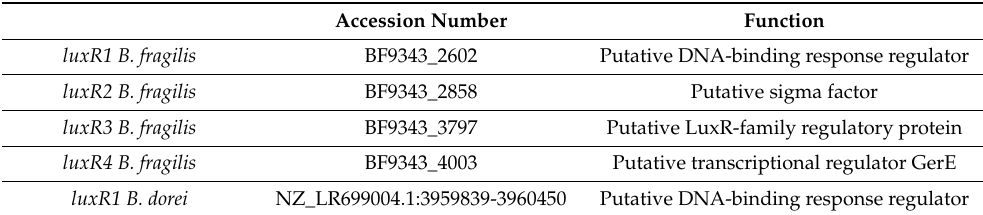
Table 2. Gene list from Bacteroides fragilis and Bacteroides